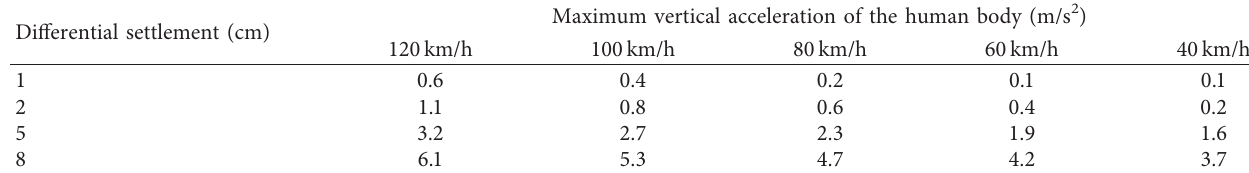
Table 7: Maximum vertical acceleration of the human body when the settlement zone length is 10